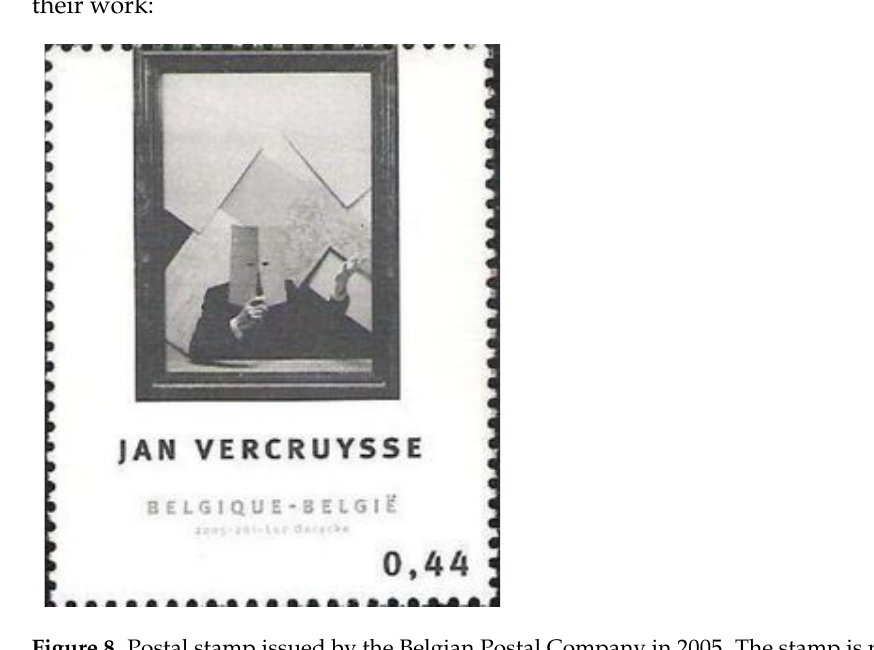
Figure 8. Postal stamp issued by the Belgian Postal Company in 2005. The stamp is part of a series on Belgian contemporary art, entitled “This is Belgium”. Other artists included in the series: Joëlle Tuerlinckx, Jef Gys, Ann Veronica Janssens, Lili Dujourie, Panamarenko, Marthe Wéry, Luc Tuy- mans, Jan Fabre and Michel